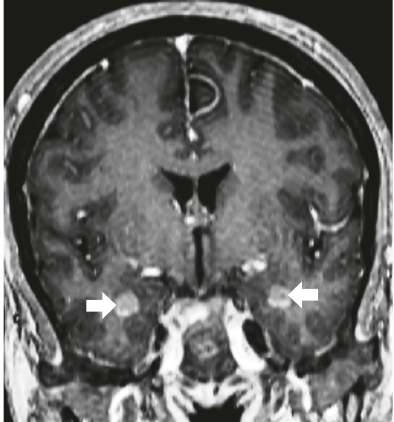
Figure3:ContrastenhancedcoronalT1weightedimageofthebrain showing bilateral well-defined enhancing lesions in the temporal poles located laterally to the amygdala (bold